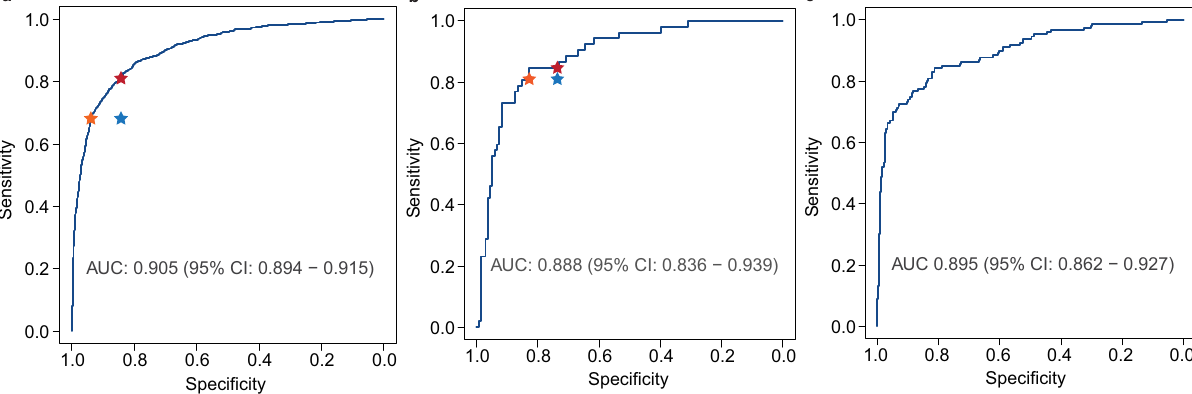
Fig. 2 The ROC curves of HTNet on three testing sets. a The fi rst internal-testing set of static images, ( b ) the second internal-testing set of video stream, ( c ) external-testing set of static images. Blue star indicates the sensitivity and speci fi city achieved by radiologists. The orange star indicates the speci fi city achieved by HTNet at the radiologists ’ sensitivity. The dark red star indicates the sensitivity achieved by HTNet at the radiologists ’ speci fi city. Area under the operating curve and associated 95% con fi dence intervals are